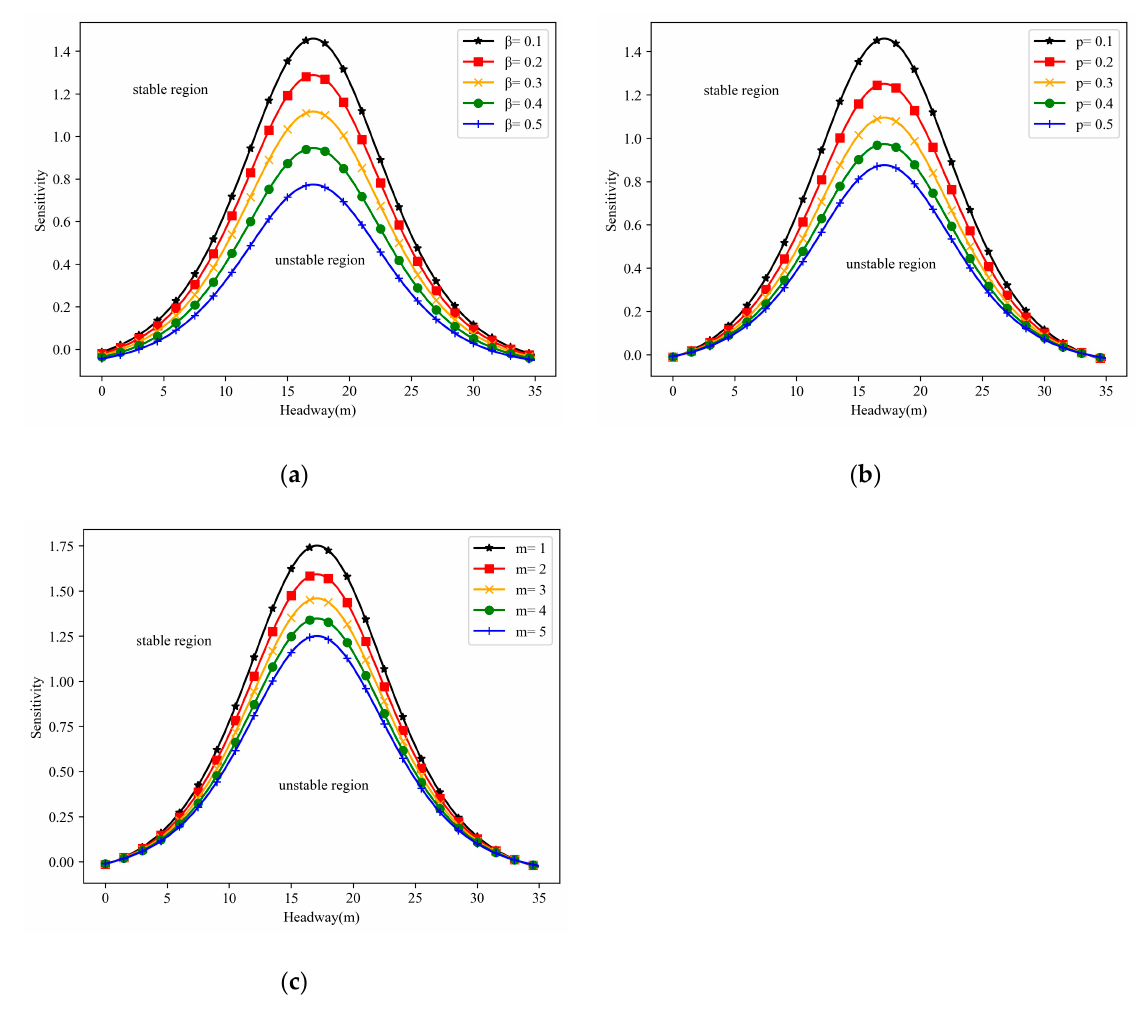
Figure 1. Critical stability curves for various parameter values: ( a ) λ = 0.1, p = 0.1, m = 3; ( b ) λ = 0.1, β = 0.1, m = 3; ( c ) λ = 0.1, β = 0.1, p = 0.1.